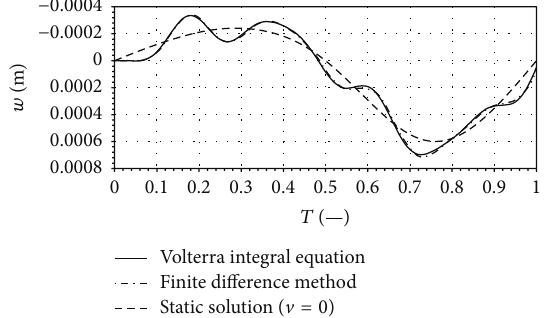
Figure 14: Dynamic deflection of point “b” (middle of the second span) due to a moving distributed